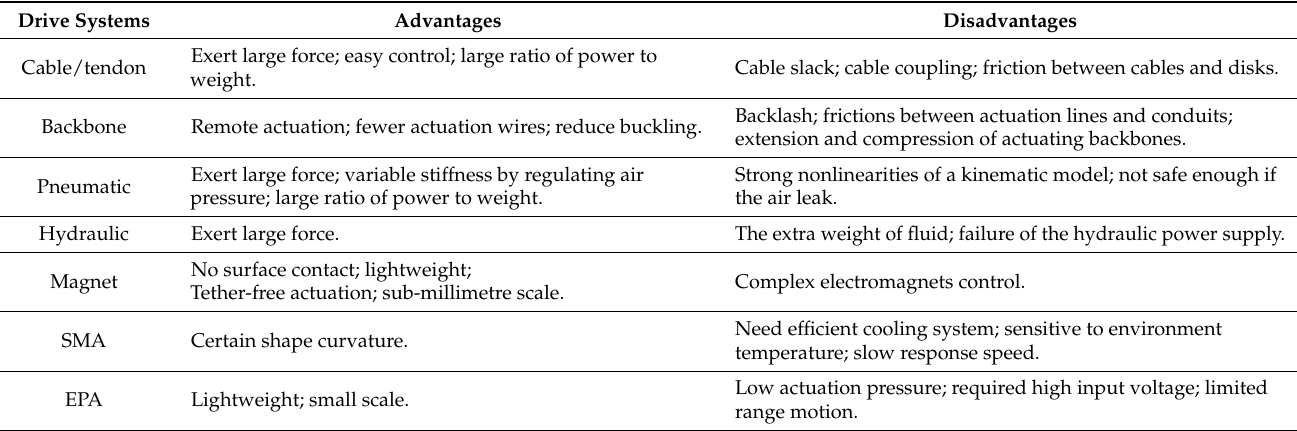
Table 3. Summary of different drive